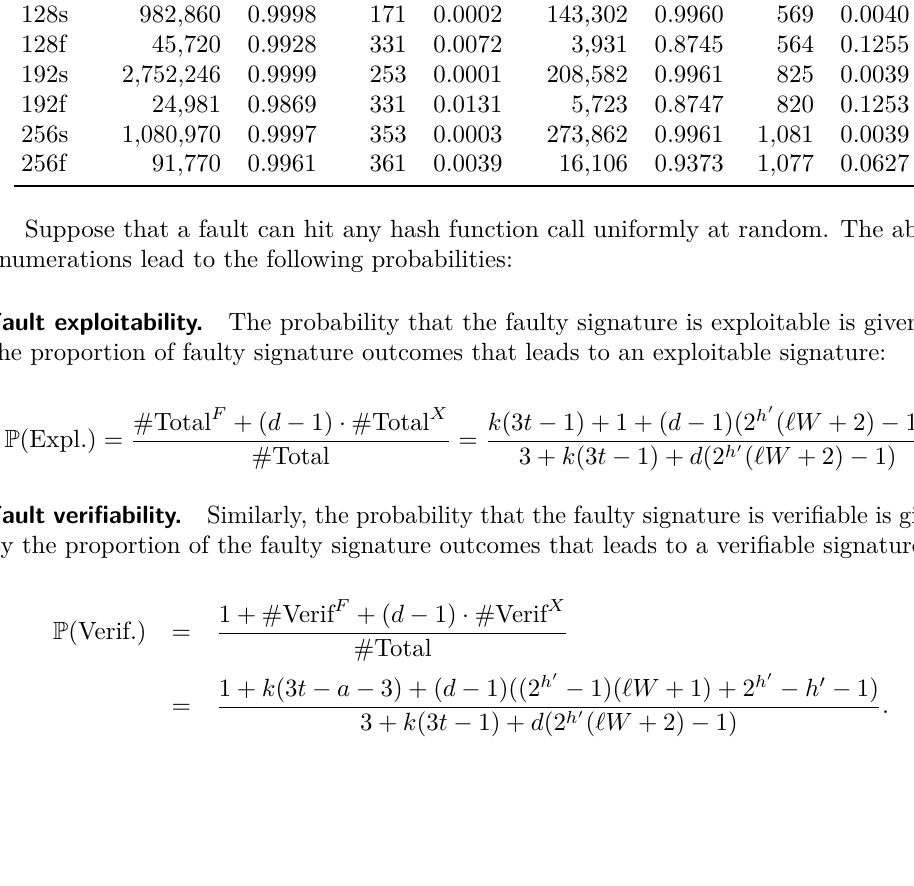
Table 3: Proportion of verifiable vs. non-verifiable signatures for faulty FORS and (non-top) XMSS for all SPHINCS + parameters sets.